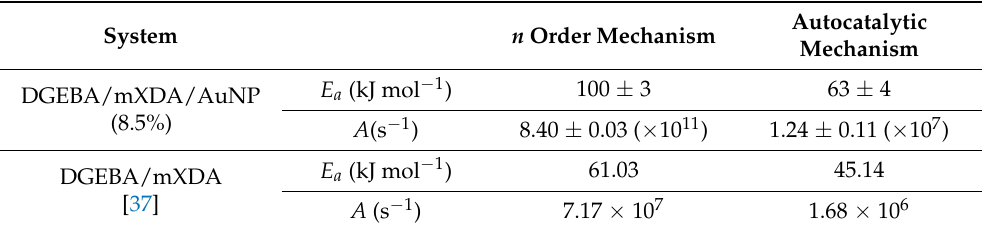
Table 3. Activation energies and pre-exponential factors (Arrhenius equation) for the n -th order and autocatalytic mechanisms.